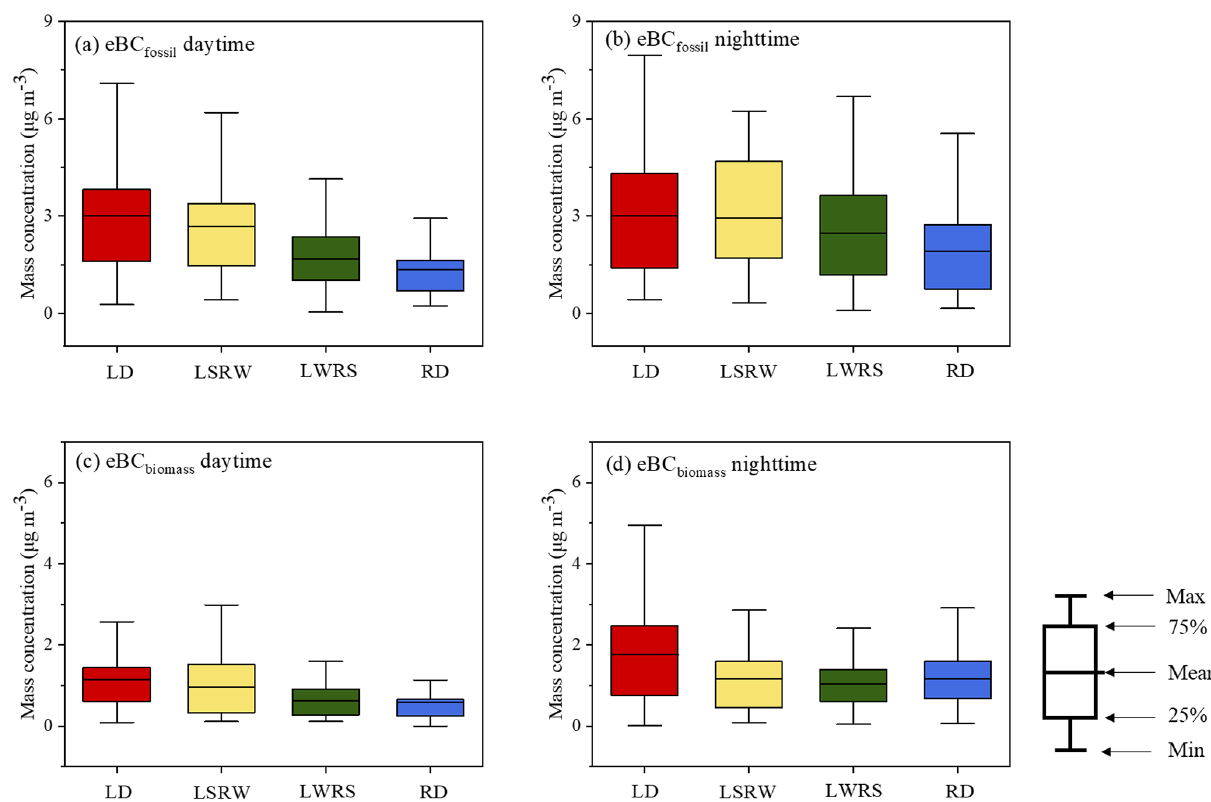
Figure 4. Mass concentrations of the e BC from fossil fuel combustion ( e BC fossil ) and the e BC from biomass burning ( e BC biomass ) during daytime (a, c) and nighttime (b, d) under LD, LSRW, LWRS, and